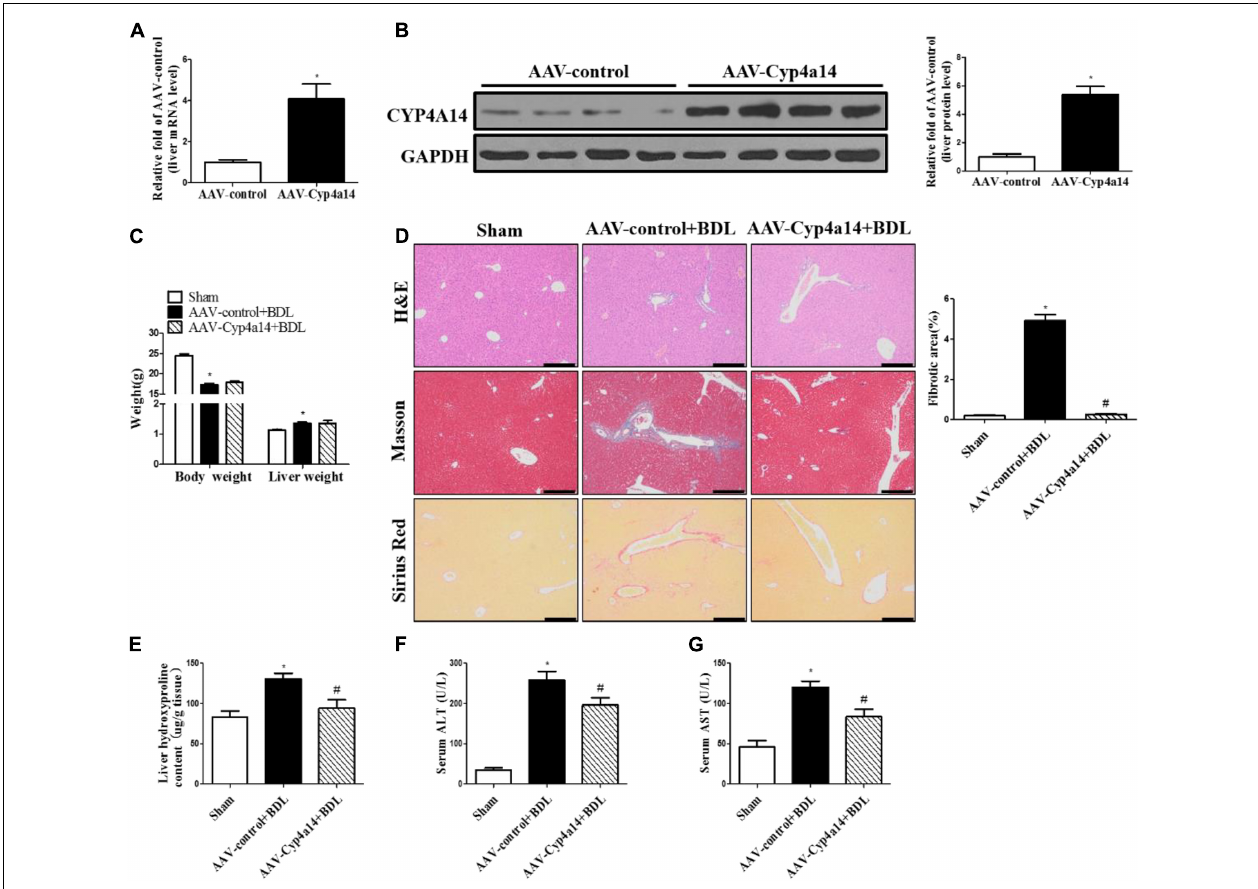
FIGURE 4 | Hepatic Cyp4a14 overexpression ameliorated bile duct ligation (BDL)-induced hepatic fibrosis. Adeno-associated virus (AAV)-control and AAV-Cyp4a14 mice were subjected to BDL for 14 days. (A) Body weight and liver weight. (B) H&E, Masson, and Sirius Red staining of the mouse liver tissues. (C) Hepatic collagen content was measured by biochemical determination of hydroxyproline (Hyp). Serum alanine aminotransferase (ALT) (D) and aspartate aminotransferase (AST) (E) levels of AAV-control and AAV-Cyp4a14 mice. n = 6–7. * p < 0.05, Sham and AAV-control + BDL. # p < 0.05, AAV-control + BDL and AAV-Cyp4a14 + BDL. Scale bar = 100 µ